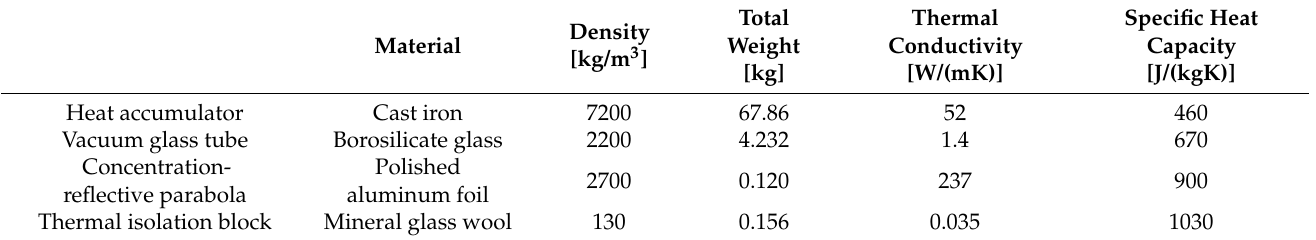
Table 1. Material, physical and thermal properties of each part of the model. Material